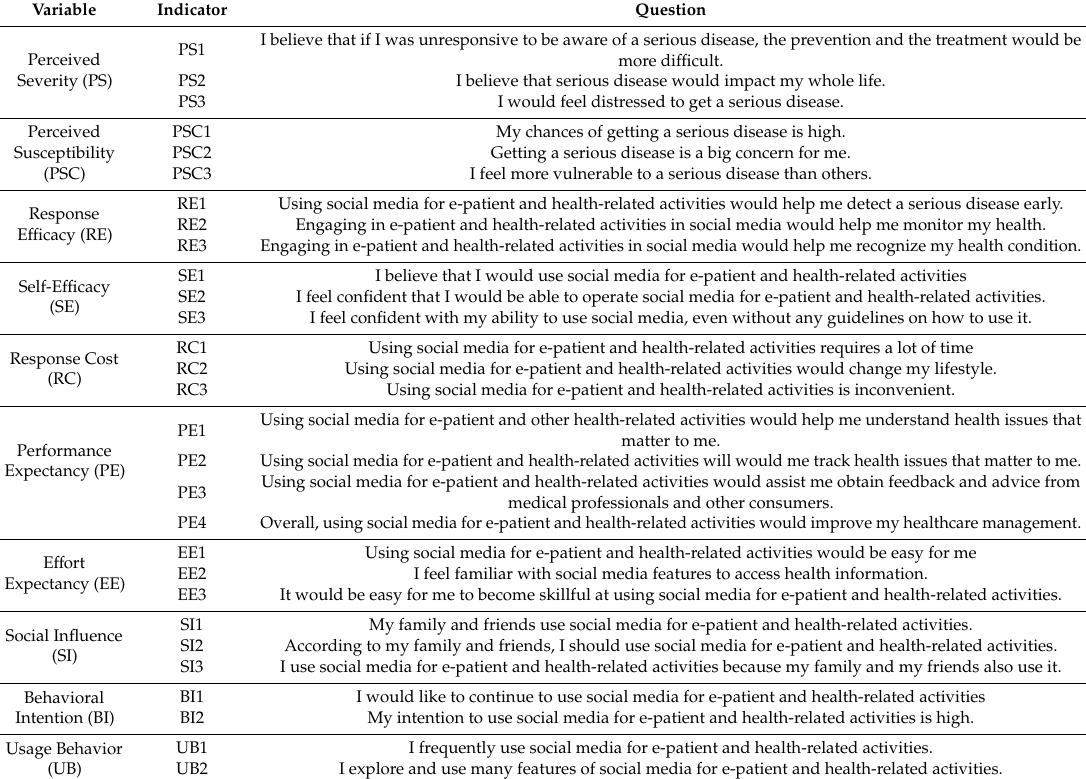
Table A1. Variable, indicator, and the corresponding question used in the